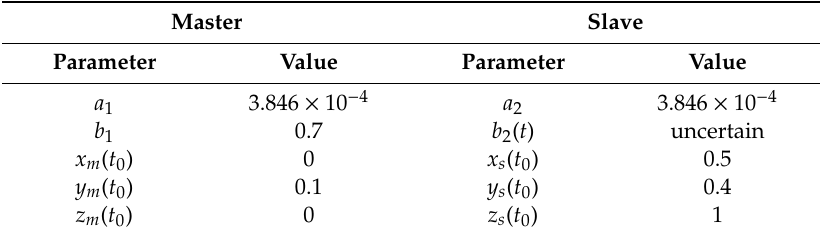
Table 1. Parameters of slave and master.